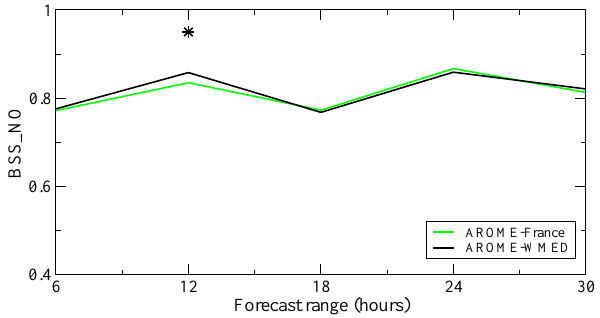
Figure 15. Brier skill score computed in a neighbouring distance of 54km for AROME-France (green) and AROME-WMED (black) for 1h wind gusts exceeding 40kmh − 1 during 6h as a function of the neighbouring during the SOP1 period ranging from 05 Septem- ber to 05 November 2012. Stars indicate where the statistical sig- nificance of the difference between the two models exceeds 90%.